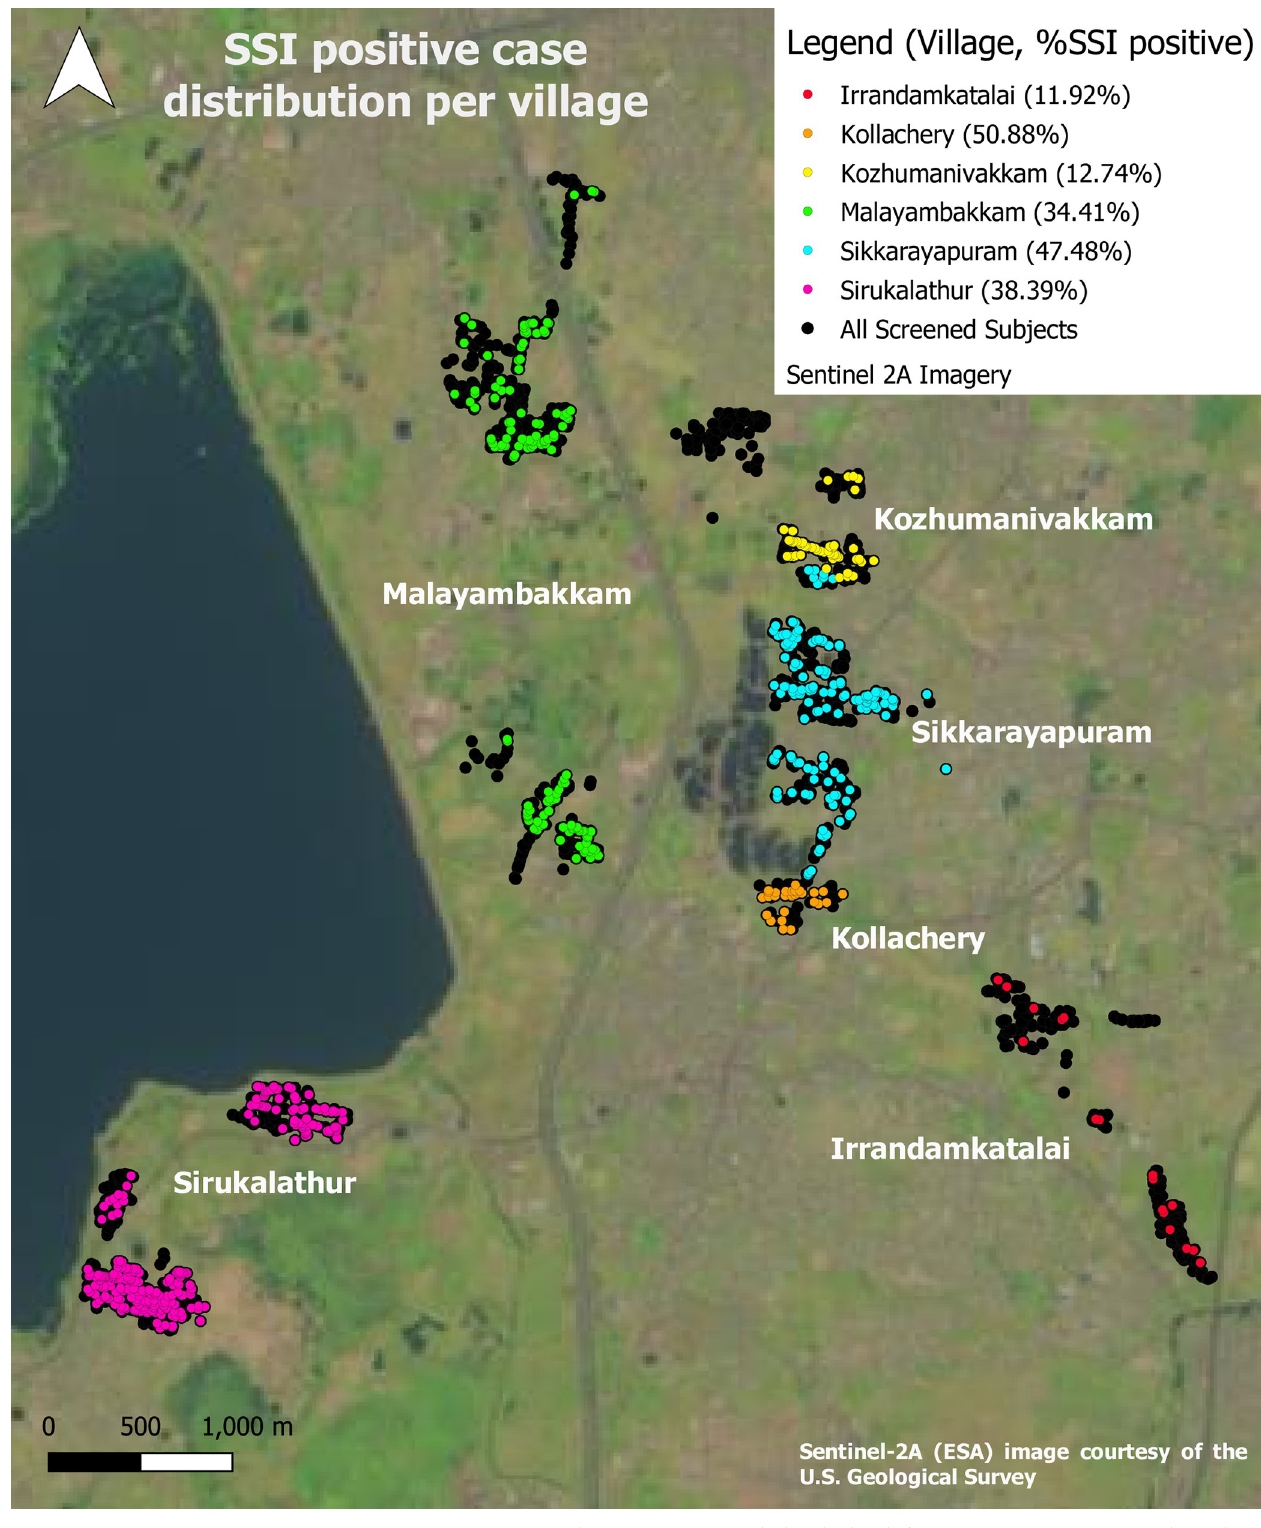
Fig 1. Distribution of Strongyloides stercoralis by study site. Map made in QGIS 3.10.11, study data displayed after processing in PostgreSQL and Pentaho. Contains information from OpenStreetMap and OpenStreetMap Foundation, which is made available under the Open Database License. OpenStreetMap data styled according to guidelines by https://github.com/charlesmillet.